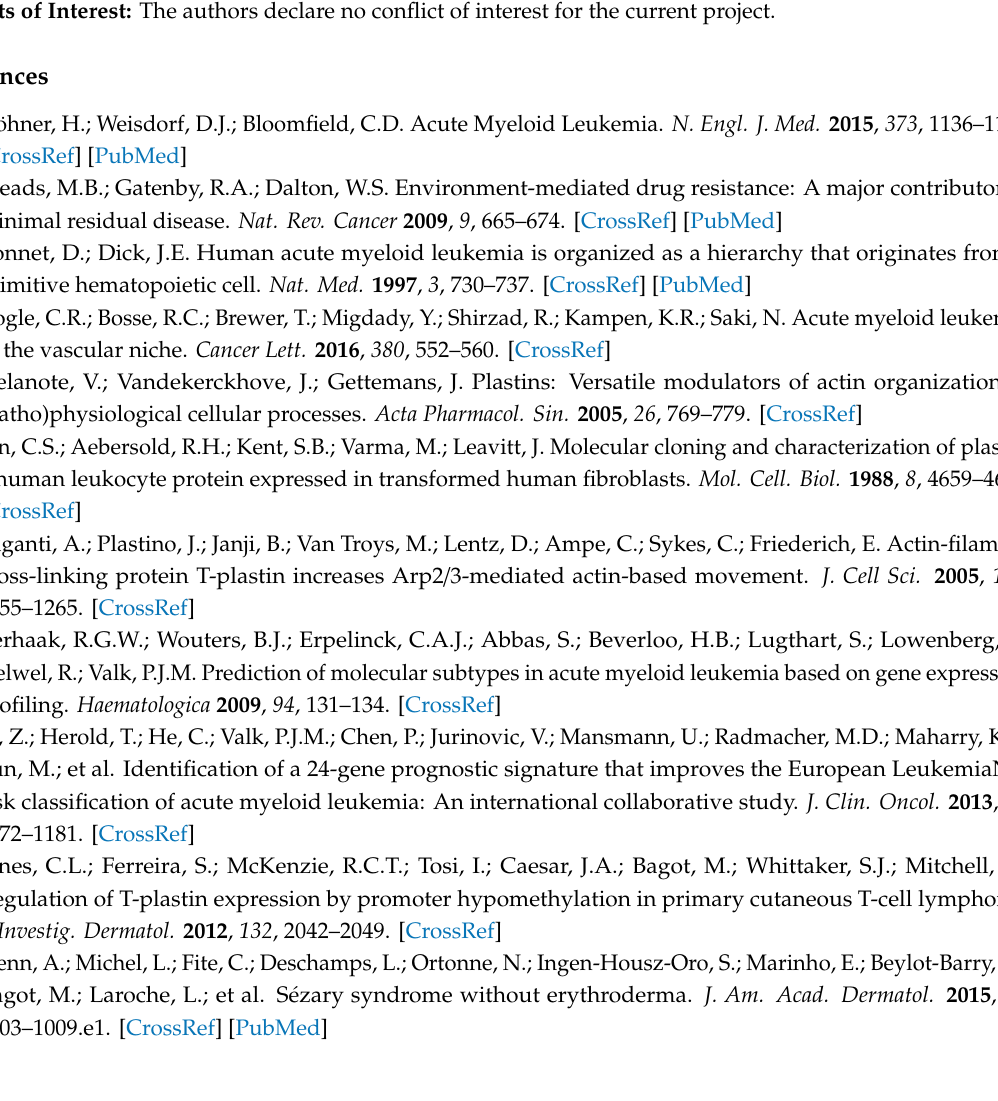
Figure S1. Knockdown and overexpression e ffi ciency of PLS3 in Kasumi-1 cells. Table S1: Microarray data of PLS3 gene expression alteration in the co-culture condition; Table S2: Genes and non-coding RNAs down-regulated in the PLS3 knockdown